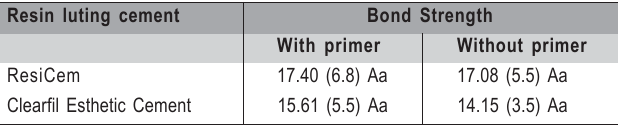
Table 2. Means (standard deviations) for microshear bond strength (MPa) of the resin luting cements to zirconia-based ceramic.